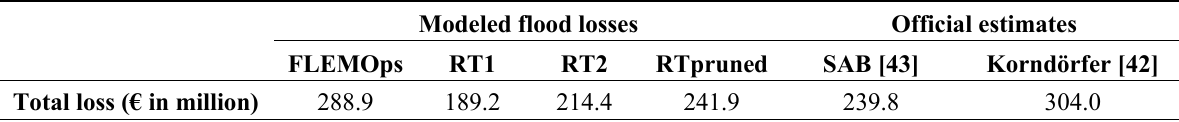
Table 6. Flood loss estimations calculated with FLEMOps and regression trees for the Elbe flood in